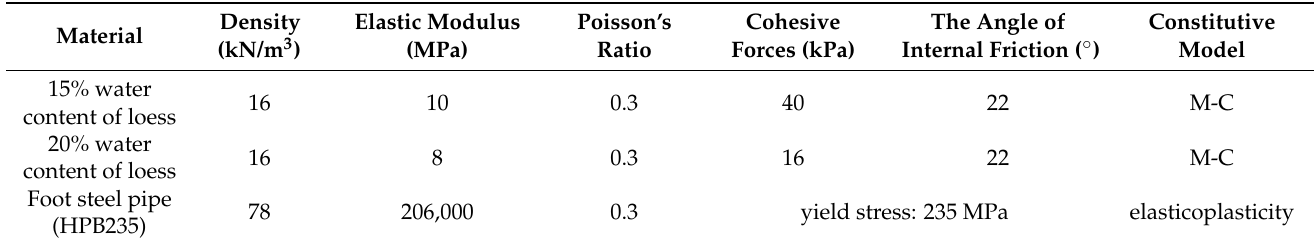
Table 1. Material parameter